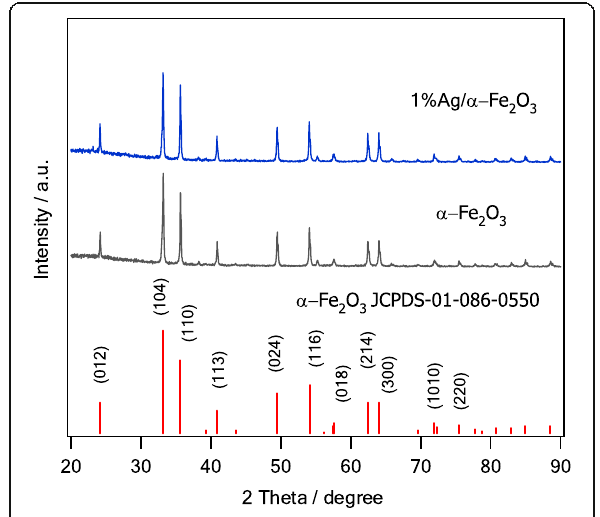
Fig. 1 XRD patterns of as-synthesized α − Fe 2 O 3 and 1%Ag/ α − Fe 2 O 3 . The standard pattern of pure α − Fe 2 O 3 is also shown